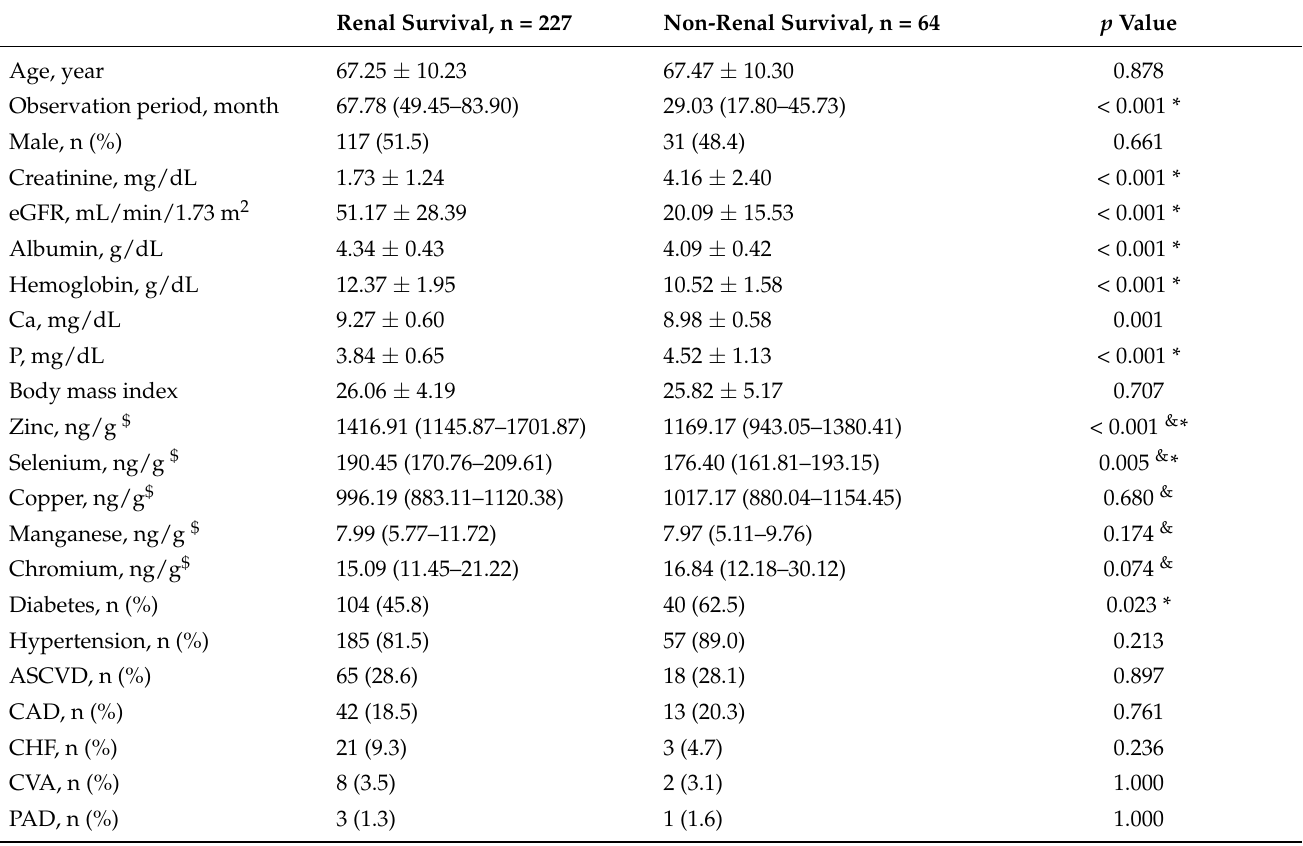
Table 1. Demographics and clinical characteristics of renal survivals and non-renal